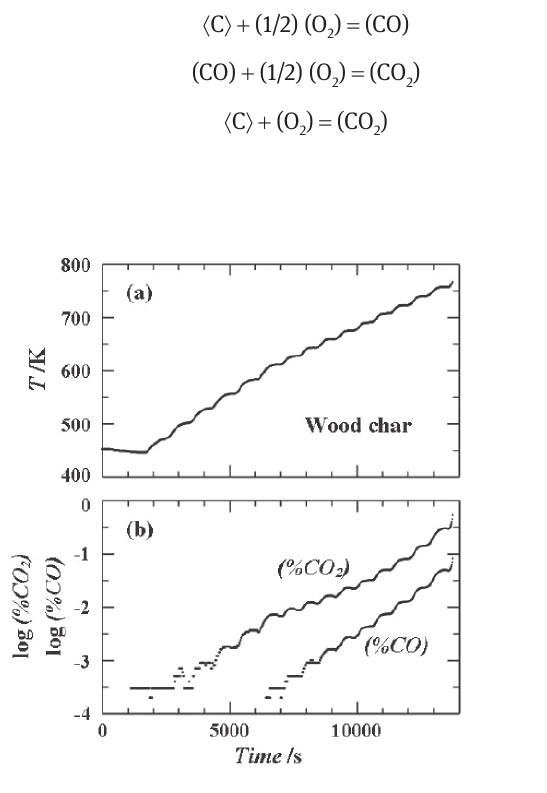
Fig. 2: Experimental apparatus for measurement of chars reactivity.